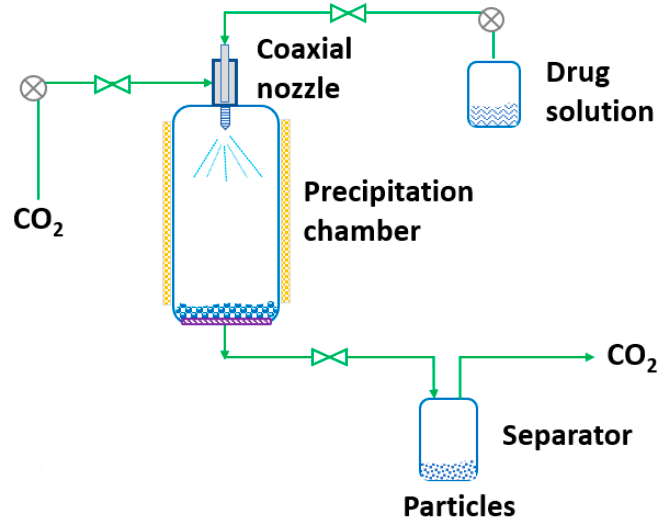
Figure 13. Solution-Enhanced Dispersion by Supercritical Fluids (SEDS) process (adapted from Tran and Park [181]).